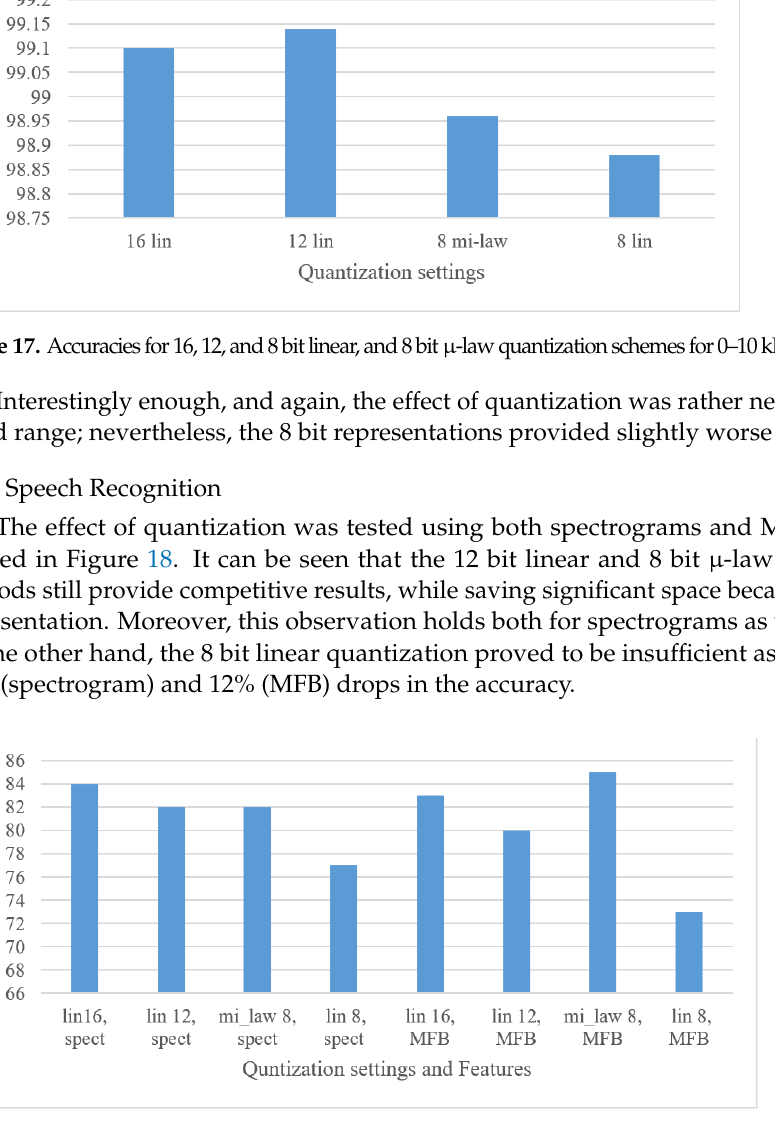
Figure 16. Averaged accuracies for 16, 12, and 8 bit linear, and 8 bit μ -law quantization schemes in the case of 1 s-long spectrograms.